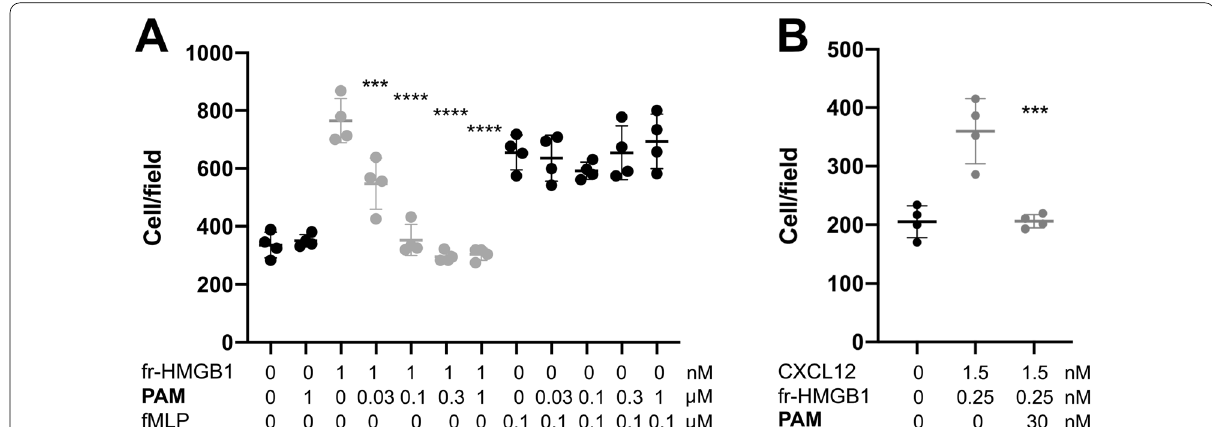
Fig. 2 A PAM inhibits HMGB1-induced, but not fMLP-induced cell migration. Mouse 3T3 fibroblasts were subjected to chemotaxis assays in Boyden chambers, 1 nM fr- (fully reduced) HMGB1, or no chemoattractant was added in the lower chamber, together with the indicated concentrations of PAM. Data points with average standard deviation (Avg SD; n 4, each point represents a biological replicate) in a representative experiment. ± ± = Statistics: one-way ANOVA (P 0.0001), followed by Dunnett’s post-tests. ***P < 0.0004, ****P < 0.0001 relative to no PAM addition. PAM does = not inhibit chemotaxis toward fMLP. Data points (n 4) with Avg SD in one representative experiment (each point represents a biological = ± replicate). Migration in the absence or in the presence of the indicated concentration of PAM is not statistically significant (Statistics: one-way ANOVA (P 0.96). B PAM inhibits chemotaxis toward the HMGB1 CXCL12 heterocomplex. Data points (n 3) with Avg SD in one representative · = = ± experiment (of three performed in different days). Migration in the presence or absence of PAM is significantly different